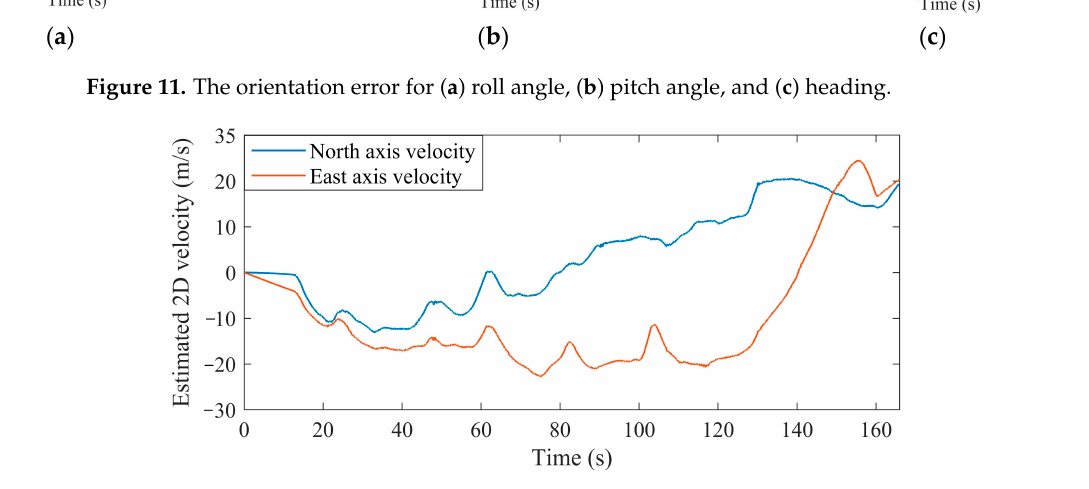
Figure 12. The estimated velocity of the ground vehicle for the North and East